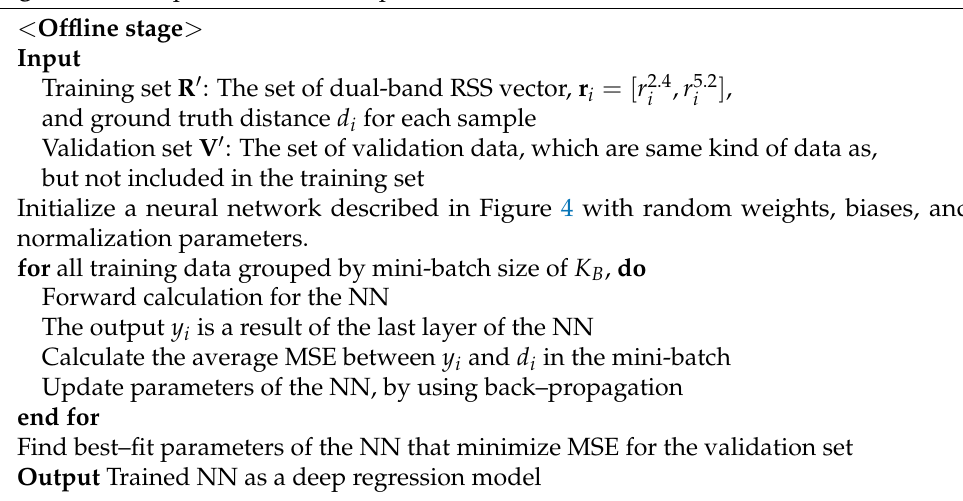
Algorithm 1 Proposed localization